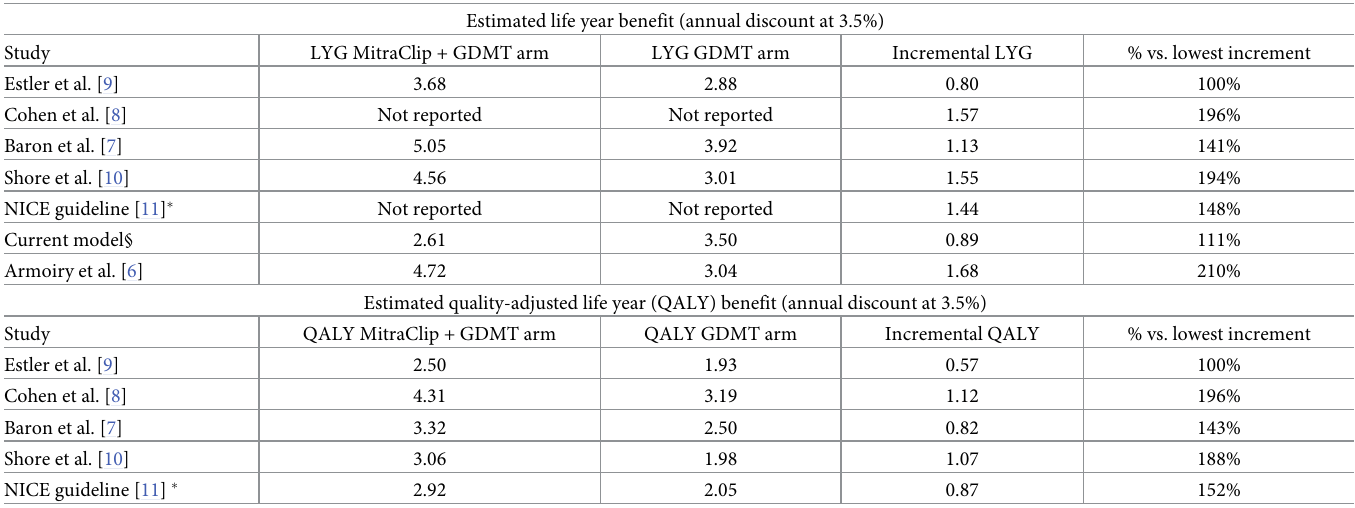
Table 1. Estimates of lifetime LYG in CE analyses discounted at 3.5% annually ¥